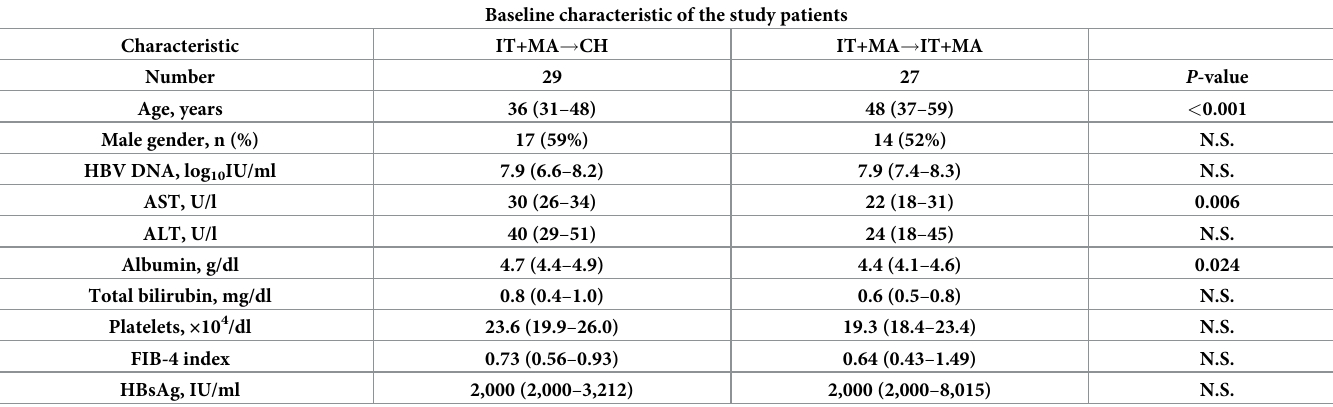
Table 2. Baseline clinical characteristics of the patients in the IT+MA phase, according to the transition of clinical phase thereafter. Baseline characteristic of the study